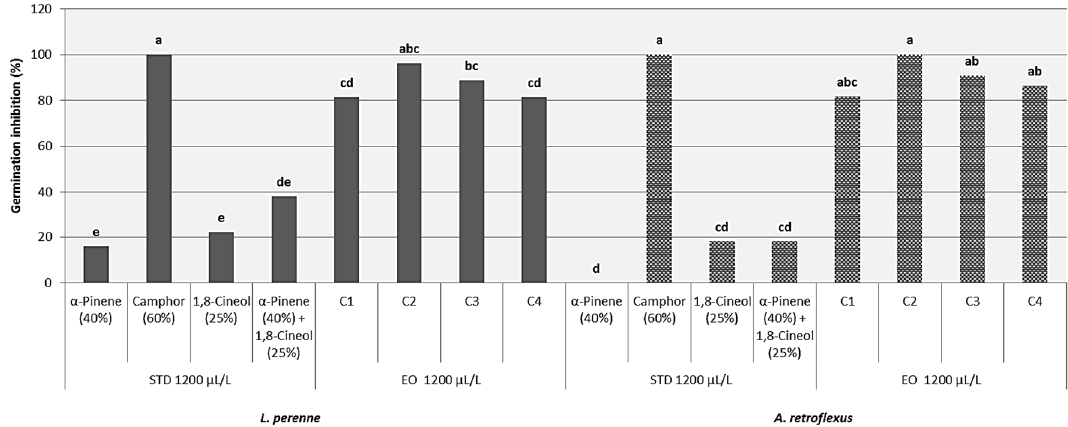
Figure 2. Comparative effect of the EOs and their corresponding main compounds at 1200 µL/L on the germination inhibition of A. retroflexus and L. perenne . C1: α -pinene, C2: camphor, C3: α -pinene/1,8-cineole, C4: α -pinene/camphor/1,8-cineole, STD: standard. Means with the same letter are not significantly different at p ≤ 0.05 significant level (Dunn test).